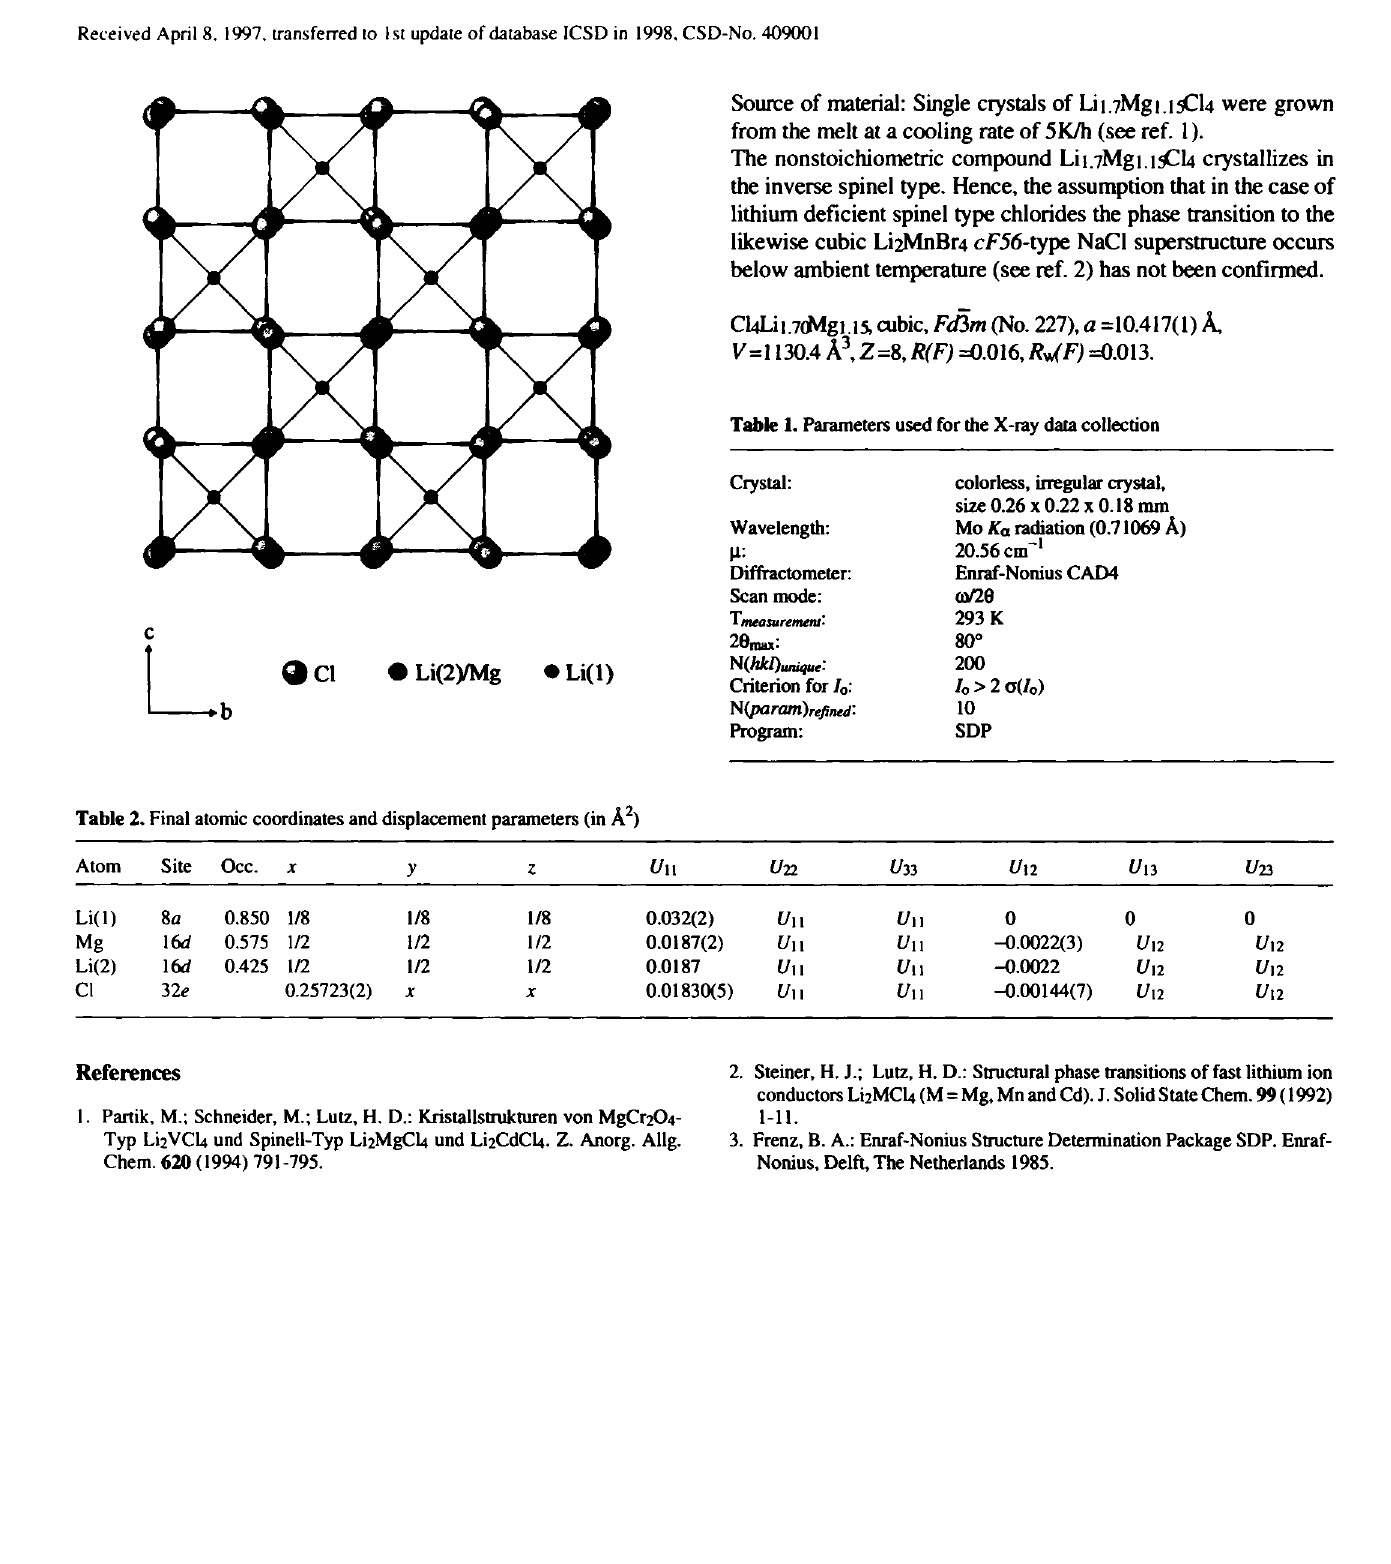
Table 1. Parameters used for the X-ray data collection